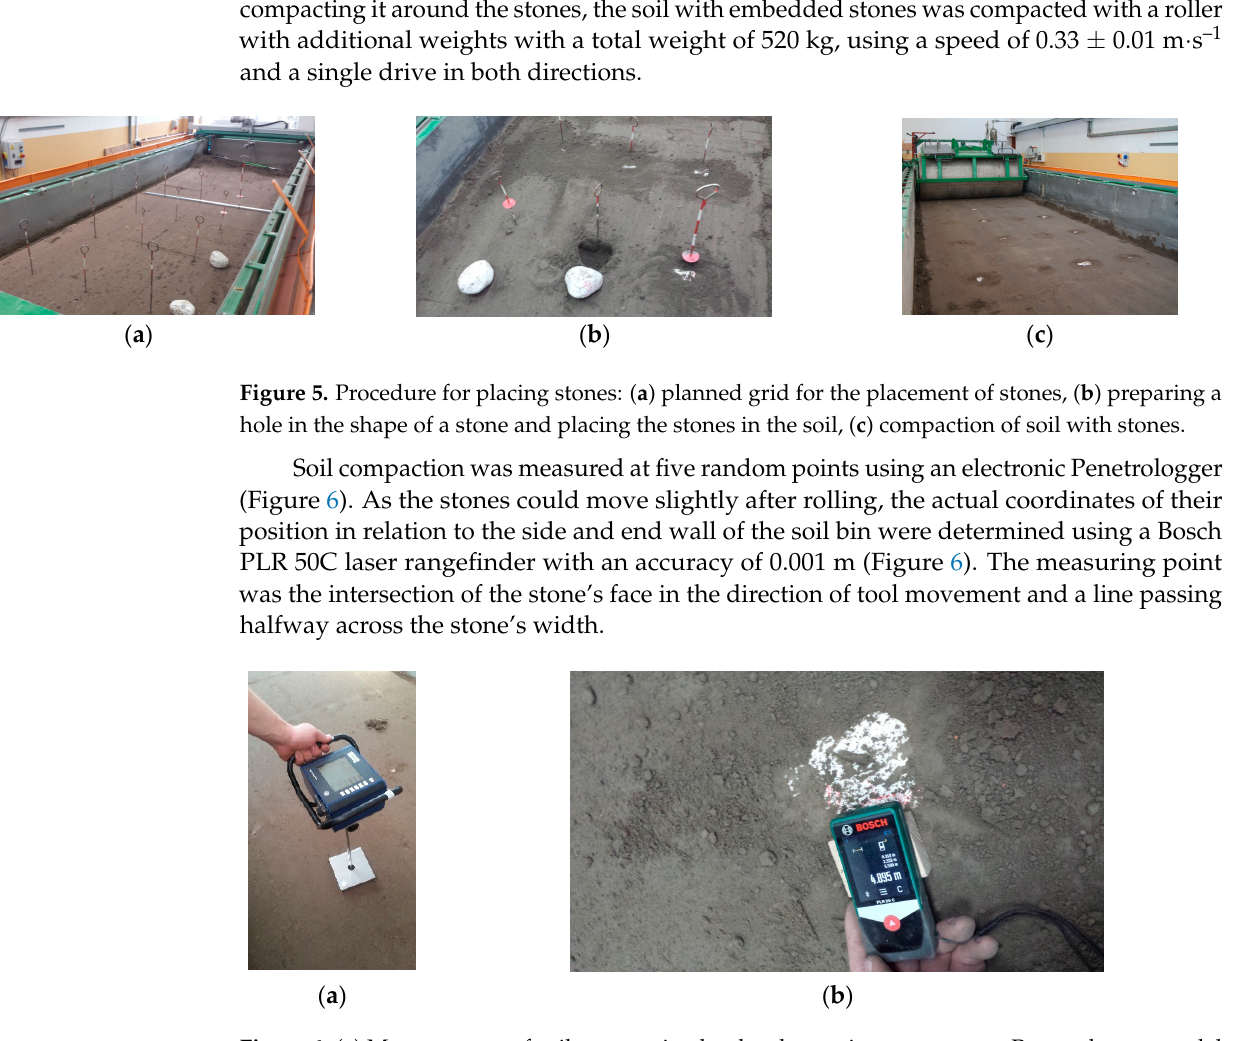
Figure 6. ( a ) Measurement of soil compaction by the electronic penetrometer Penetrologger model 06.15.SA and ( b ) stone placement in prepared soil and measurement of the initial position of the stone using the Bosch PLR 50C laser rangefinder.